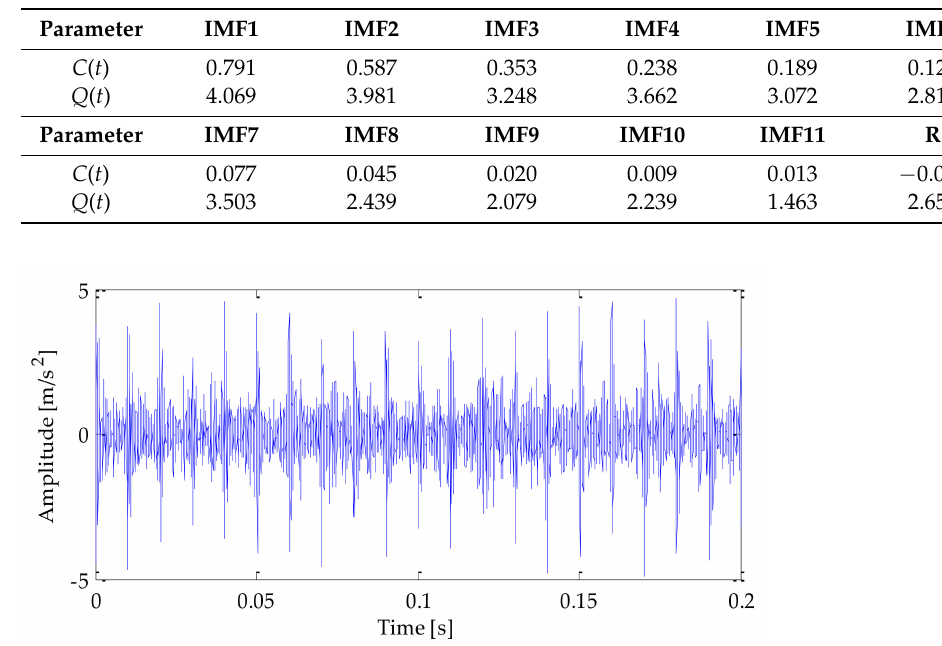
Table 4. Index values of different IMF signal components (EEMD).